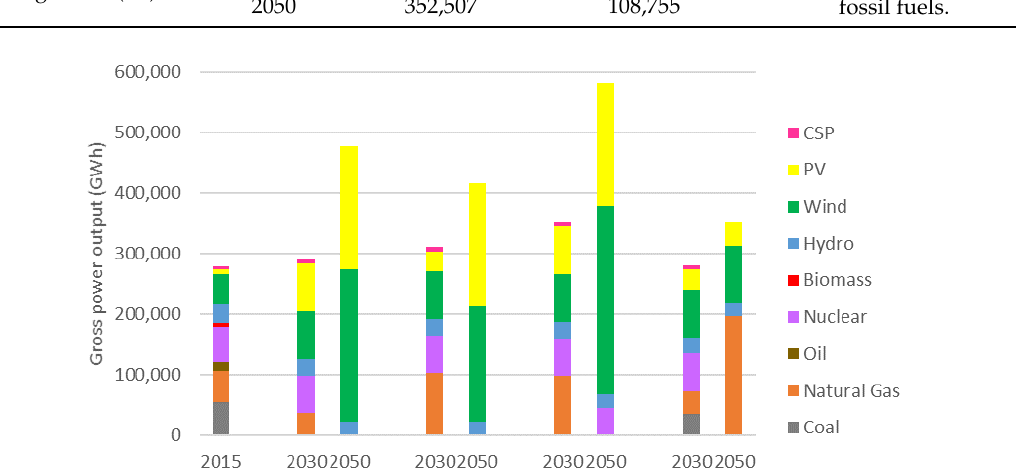
Figure 5. Projections of installed capacity and technology mix in Spain (2030–2050) compared to reference year 2015. The decarbonisation (DC) scenario assumes the implementation of ambitious strategies to confront climate change and achieve a 40% reduction in GHG by 2030 and a 95% one by 2050, according to the objectives set by Member States of the European Union [9,10]. As shown in Figure 4, the DC scenario assumes a small increase in overall power consumption by 2030, as well as a complete elimination of coal and oil, a continuation of nuclear power and a slight reduction of natural gas from the electricity mix. This scenario also considers a significant increase in power demand by 2050, which is covered entirely by renewable sources, primarily PV and wind (hydropower remains stable due to limitations in the availability of additional hydroelectric resources in Spain). The current policies (CP) scenario assumes a linear evolution of international geopolitics concerning the use of renewables and restraints in the emission of GHG. This scenario considers complete elimination of coal and oil from the electricity mix by 2030, assuming that this is largely replaced by natural gas, which absorbs 33% of the demand. By 2050, the CP scenario describes complete coverage of power demand from renewables, for an overall generation that is 15% lower than that in the DC scenario. The CP scenario would not accomplish the 95% GHG cuts proposed by the European Commission by 2050 [10]. The accelerated technology advance (AT) scenario presumes a rapid reduction in the cost of technologies related to renewable energies, energy storage and electricity consumption, including a fast transition into the electrification of transport. As shown in Figure 2, this would result in higher power demands than observed in the other scenarios and higher penetration of renewables as well